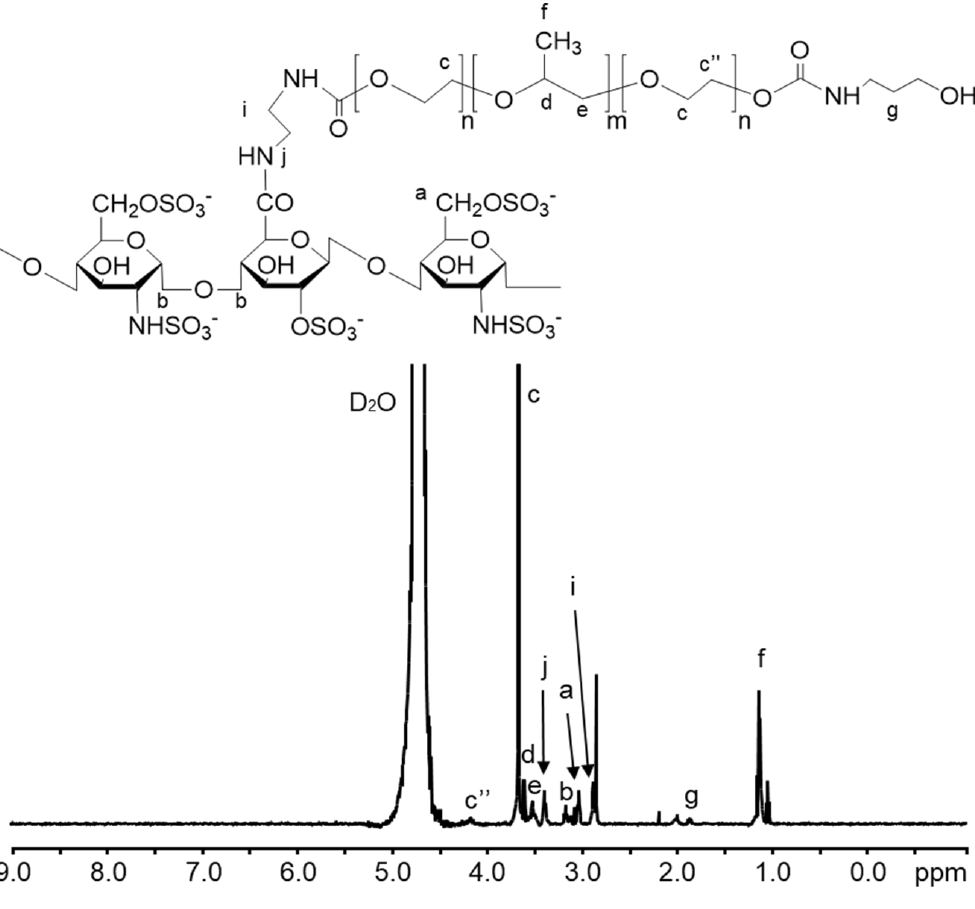
Figure 2. 1 H-NMR spectrum (D 2 O, δ in ppm) of the HP copolymer and chemical structure of HP. Signals (a-g) were assigned to HP’s structure .